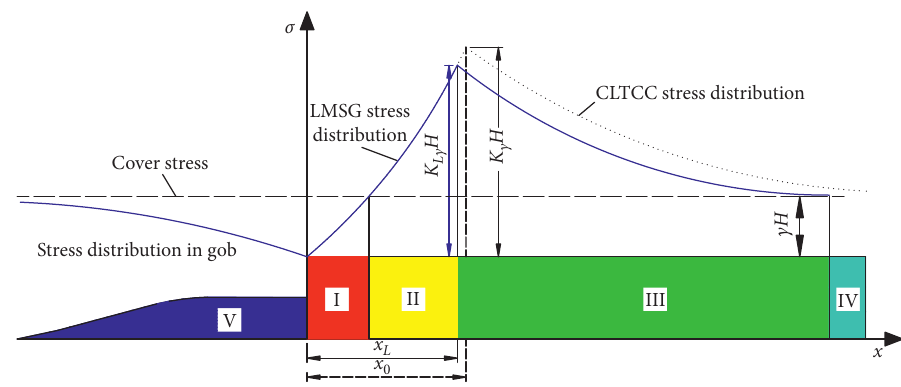
Figure 4: Elastoplastic zone and abutment pressure of